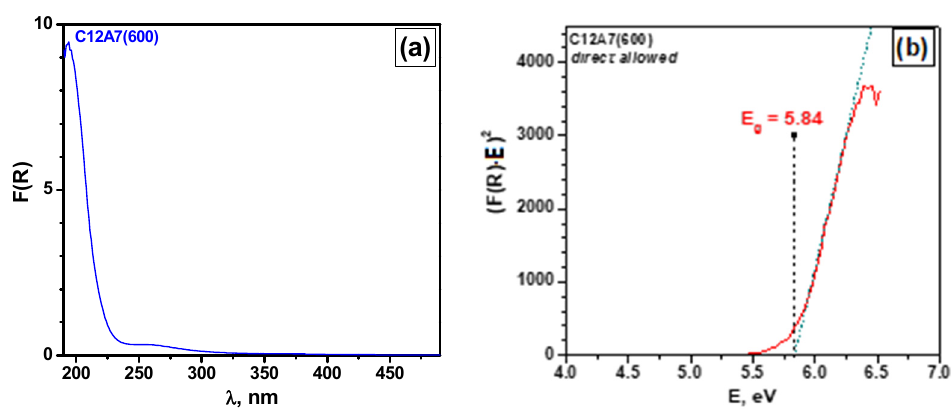
Figure 3. Diffuse reflectance UV–Vis spectrum of pure mayenite calcined at 600 °C ( a ). Dependence of ( F ( R ) · E ) 2 on the photon energy E characterizing the energy gap width E g for the direct allowed transitions ( b ).